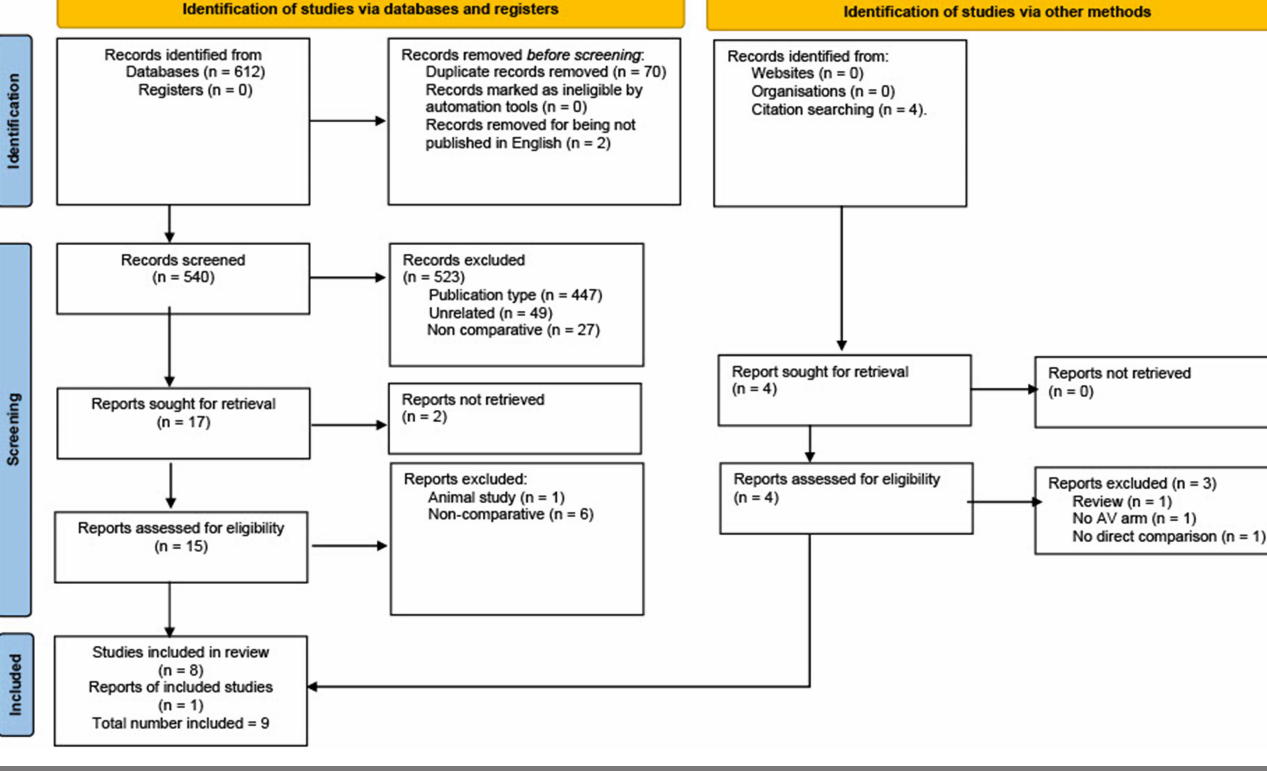
Figure 1. The PRISMA flow chart for the results of literature search and study selection. PRISMA, Preferred Reporting Items for Systematic Reviews and